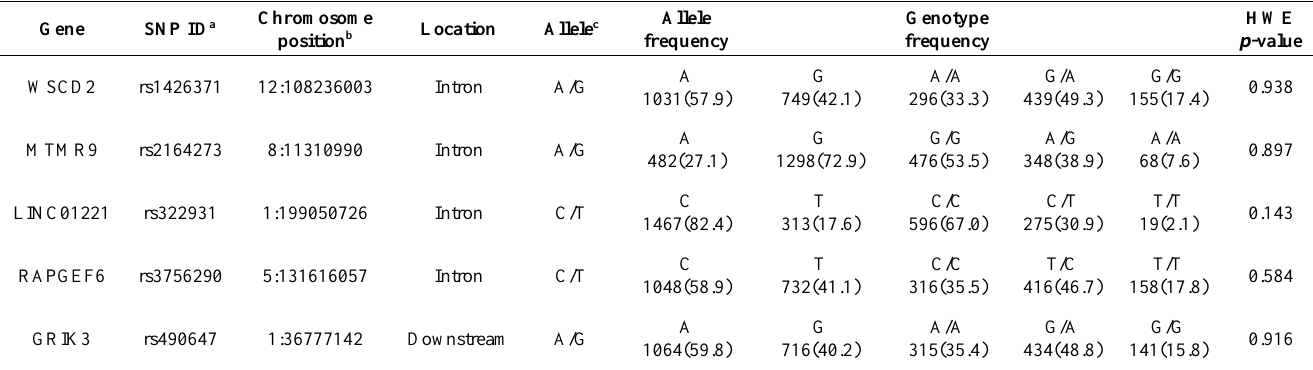
Table 1. The five SNPs analysed in this study and the distribution of alleles and genotypes in 890 participants